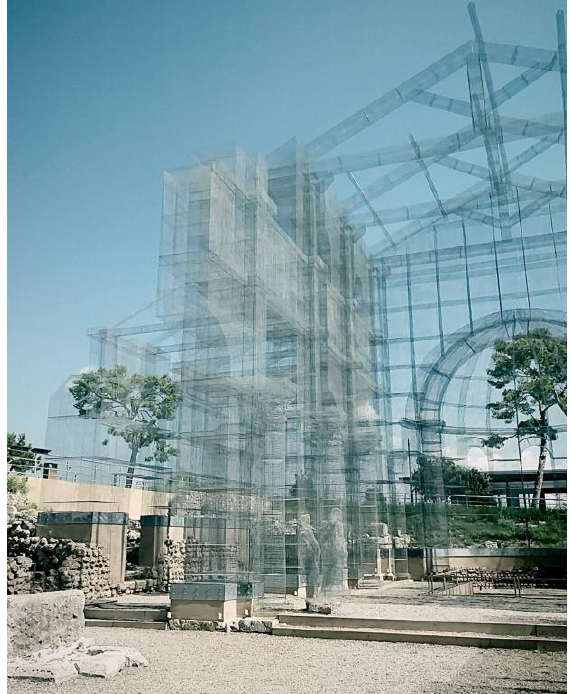
Figure 2. Evocative reconstruction of the Siponto Basilica, Tresoldi 2016 (ph. D.